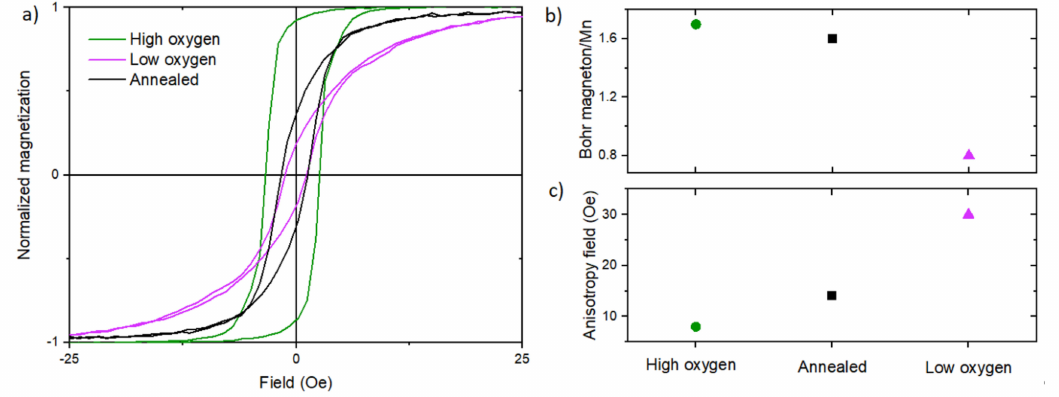
Figure 6. ( a ) The magnetic hysteresis loops measured by VSM along the hard axis of: a rapidly cooled LSMO / STO sample after sputtering (pink), the same sample after 1 h oxygen annealing at 800 ◦ C (black), and a slowly cooled LSMO / STO sample with simultaneous continuous addition of oxygen up to the value of 50 Torr (green). ( b ) The saturation magnetization of LSMO per manganese atom and the anisotropy field of a rapidly cooled LSMO / STO sample after sputtering (pink triangle), the same sample after 1 h oxygen annealing at 800 ◦ C (black square), and a slowly cooled LSMO / STO sample with simultaneous continuous addition of oxygen up to the value of 50 Torr (green circle). ( c ) The anisotropy field of abovementioned